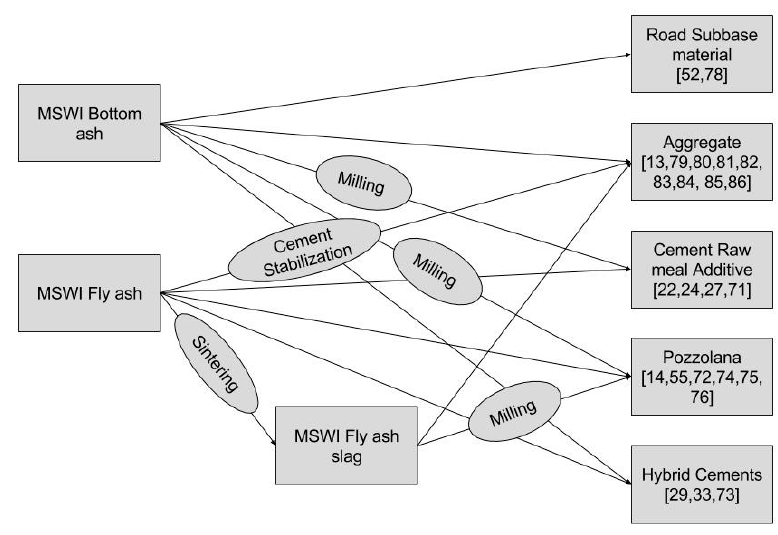
Figure 6. Routes of valorization for MSWI ash.